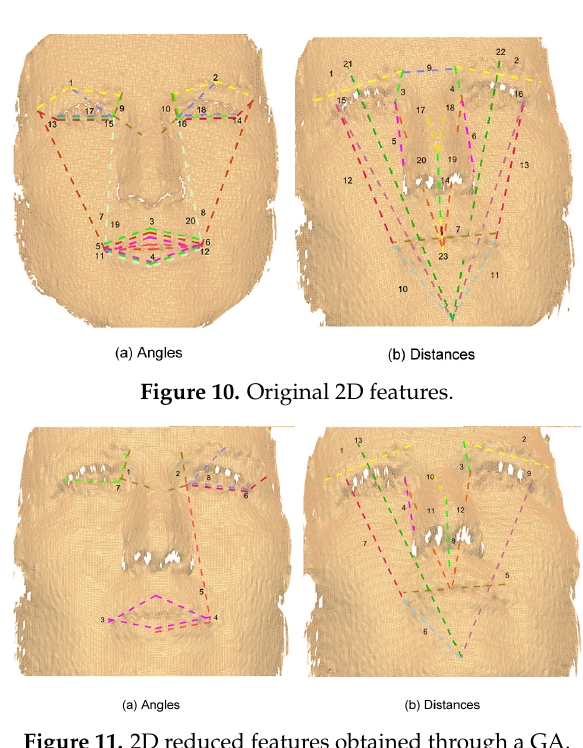
Figure 11. 2D reduced features obtained through a GA.